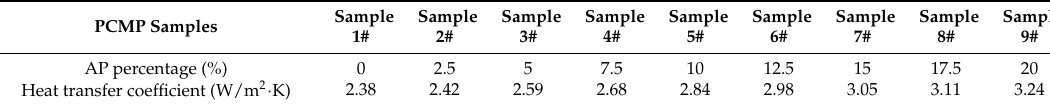
Table 7. Heat transfer coefficients with different AP percentage.